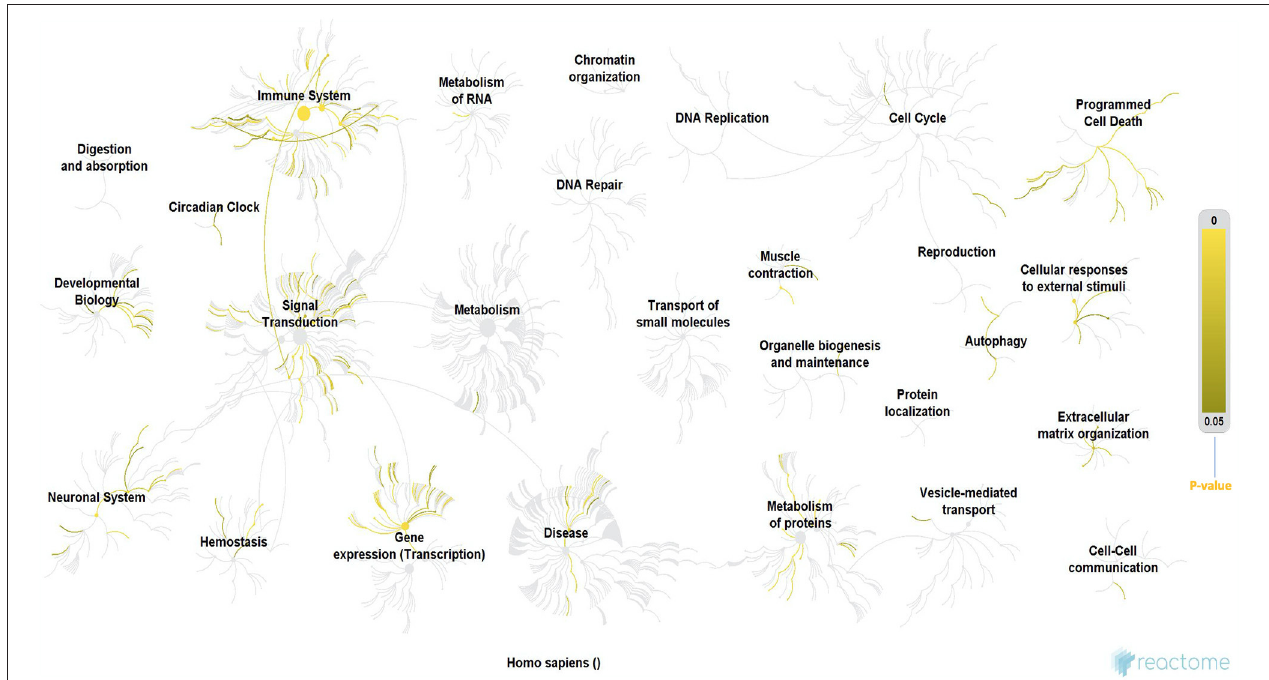
FIGURE 3 | Reactome analysis of all the genes known to date in literature for their involvement in ALS. Even though these genes are not forming tigther networks between them, they still maintain cross-functionality through direct or indirect co-dependence, which also suggests that there are still unknown genes in the puzzle that may form the missing link. The processes highlighted in this Reactome analysis appear to be involved in ALS from early to late stages ( 60) and they form cross-functional networks that guide or impinge on the process of neurodegeneration. The color-intensity scale for p -values for each of the significant processes in the Reactome is shown on the right-hand side of the figure. Immune system, circadian clock, signal transduction, RNA and protein metabolism, gene expression/transcription, neuronal system, homeostasis, programmed cell death (apoptosis), muscle contraction and authophagy were some of the most significant networks in the reactome, which is consistent with various hypotheses proposed for ALS in this review, in addition to their role converging to cause neurodegeneration. Methodology : There were a total of 3713 mRNA genes that we looked at in the analysis. We filtered out all genes with log 2-fold changes < 1 but > − 1 and then focused on the up-regulated genes of which there were 576. The gene symbols of these genes were imported into Reactome, which was able to match 385 gene symbols to known identifiers. These 385 up-regulated genes were used by Reactome to perform over representation analysis which was the basis of our functional analysis. We performed this analysis on Reactome version 68 (released on 16/05/2019) ( 60, 61). PS: ( All ALS-related genes included in the Reactome analysis are listed in the Supplementary File 1 )